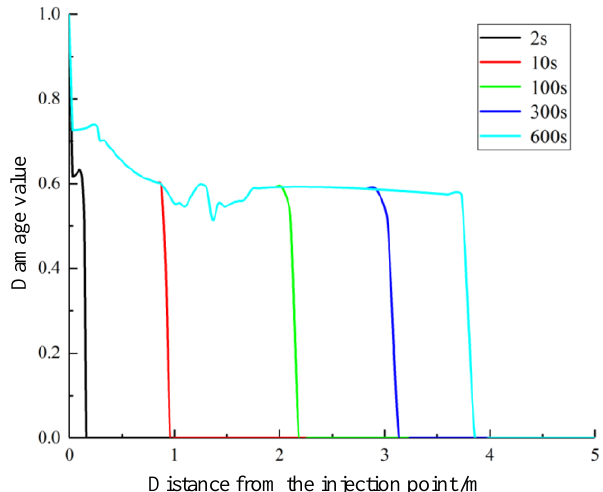
Figure 9. The distribution of damage value along the axial extension path with the distance from the injection point at different times.